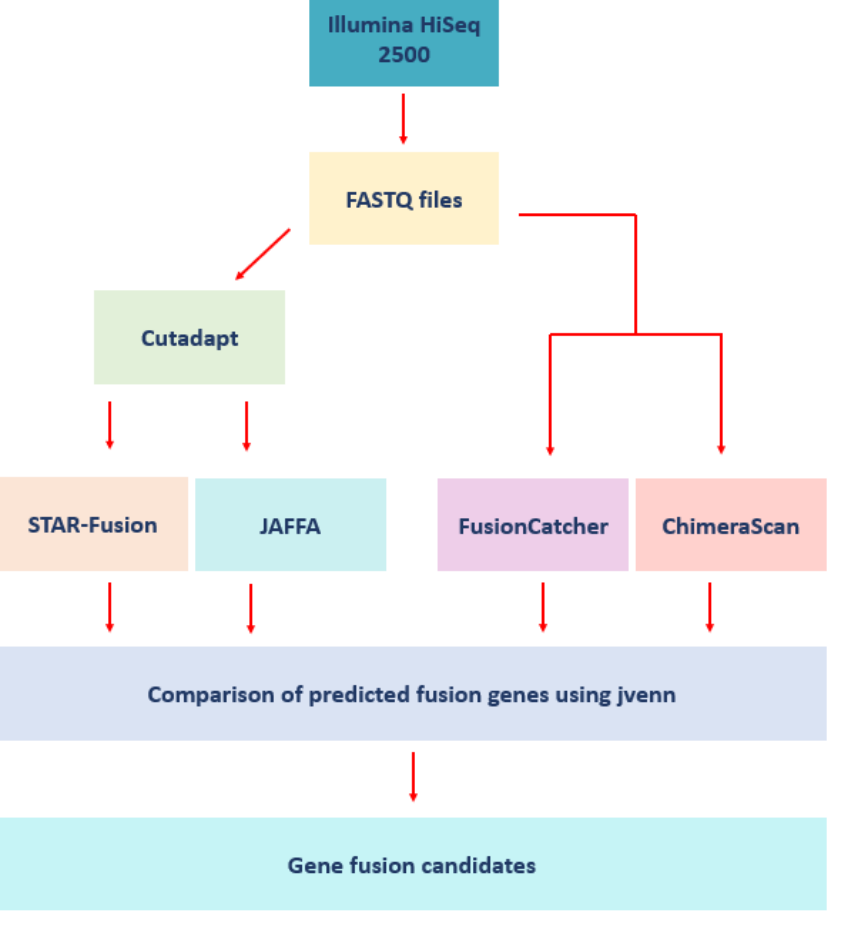
Figure 1. Workflow schematic. Fastq files were inputted to FastQC and Cutadapt. Four separate gene fusion tools predicted gene fusions that were compared using jvenn.